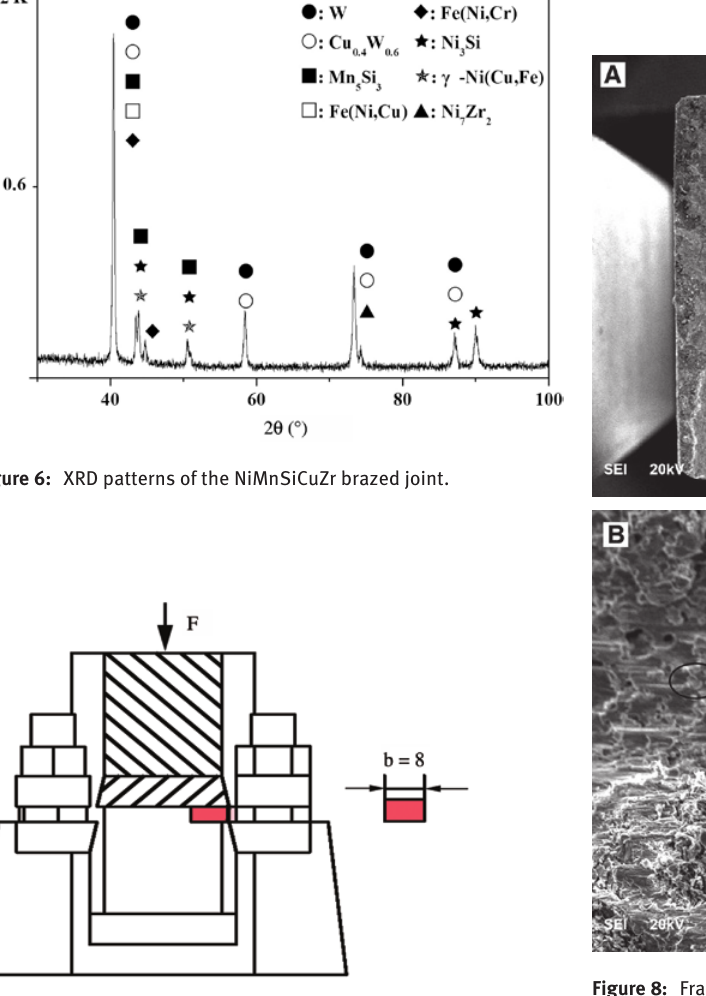
Figure 7: Sketch of shear test.